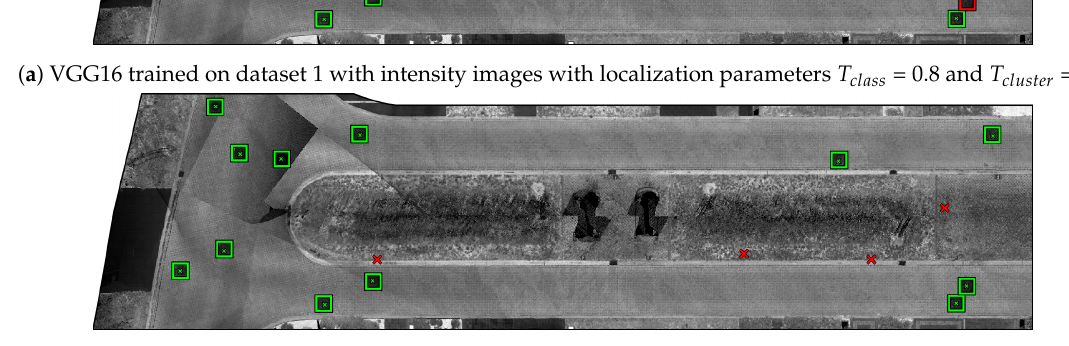
( b ) VGG16 trained on dataset 2 with intensity images with localization parameters T class = 0.9 and T cluster = 16.